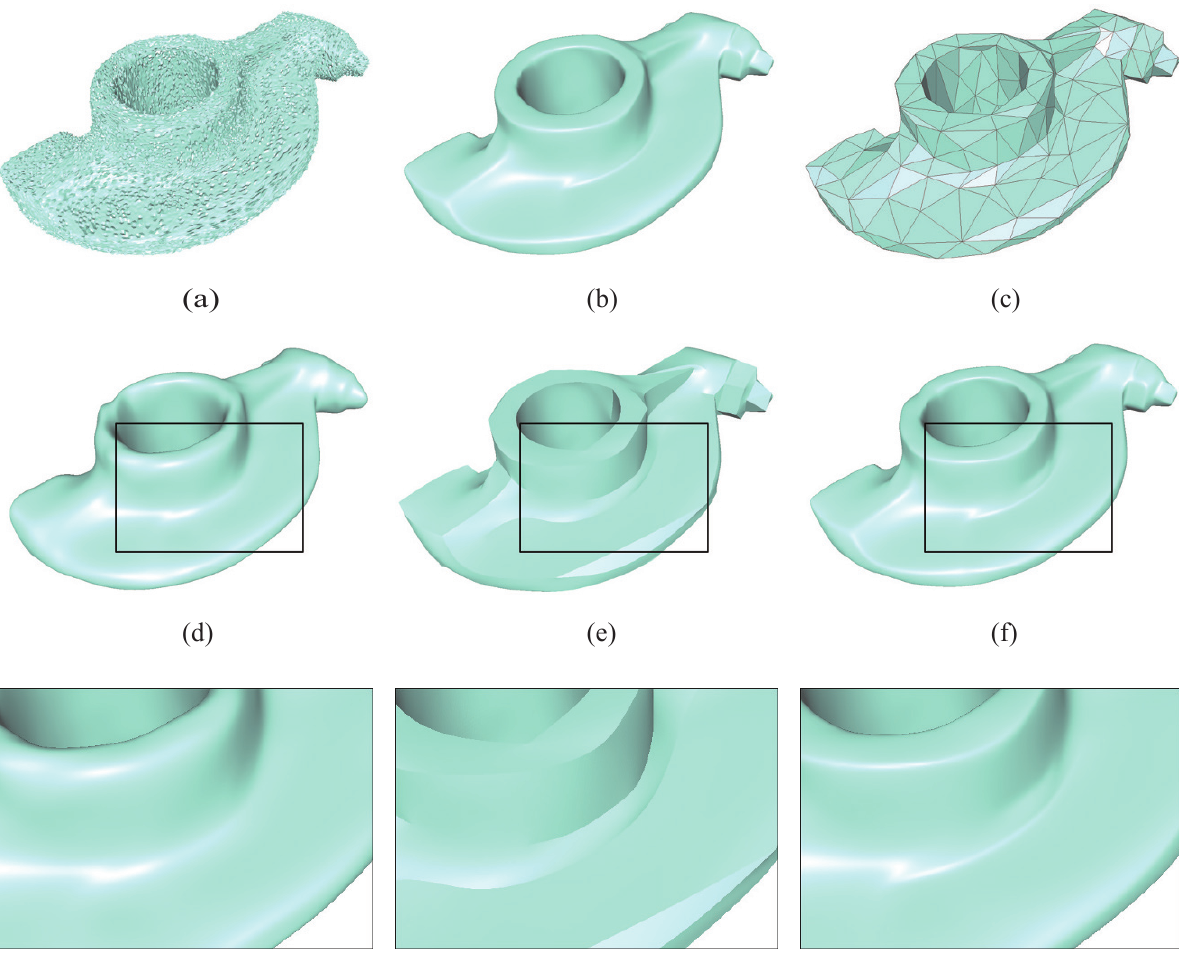
Fig. 6 Rocker arm model: (a) noisy dense mesh, (b) mesh after denoising, (c) initial mesh obtained by simplification, (d) subdivision surface reconstructed by Loop subdivision, (e) subdivision surface using the rules in Ref. [2], and (f) reconstructed subdivision surface using our method. The bottom row shows close-up views of the subdivision surfaces in the row